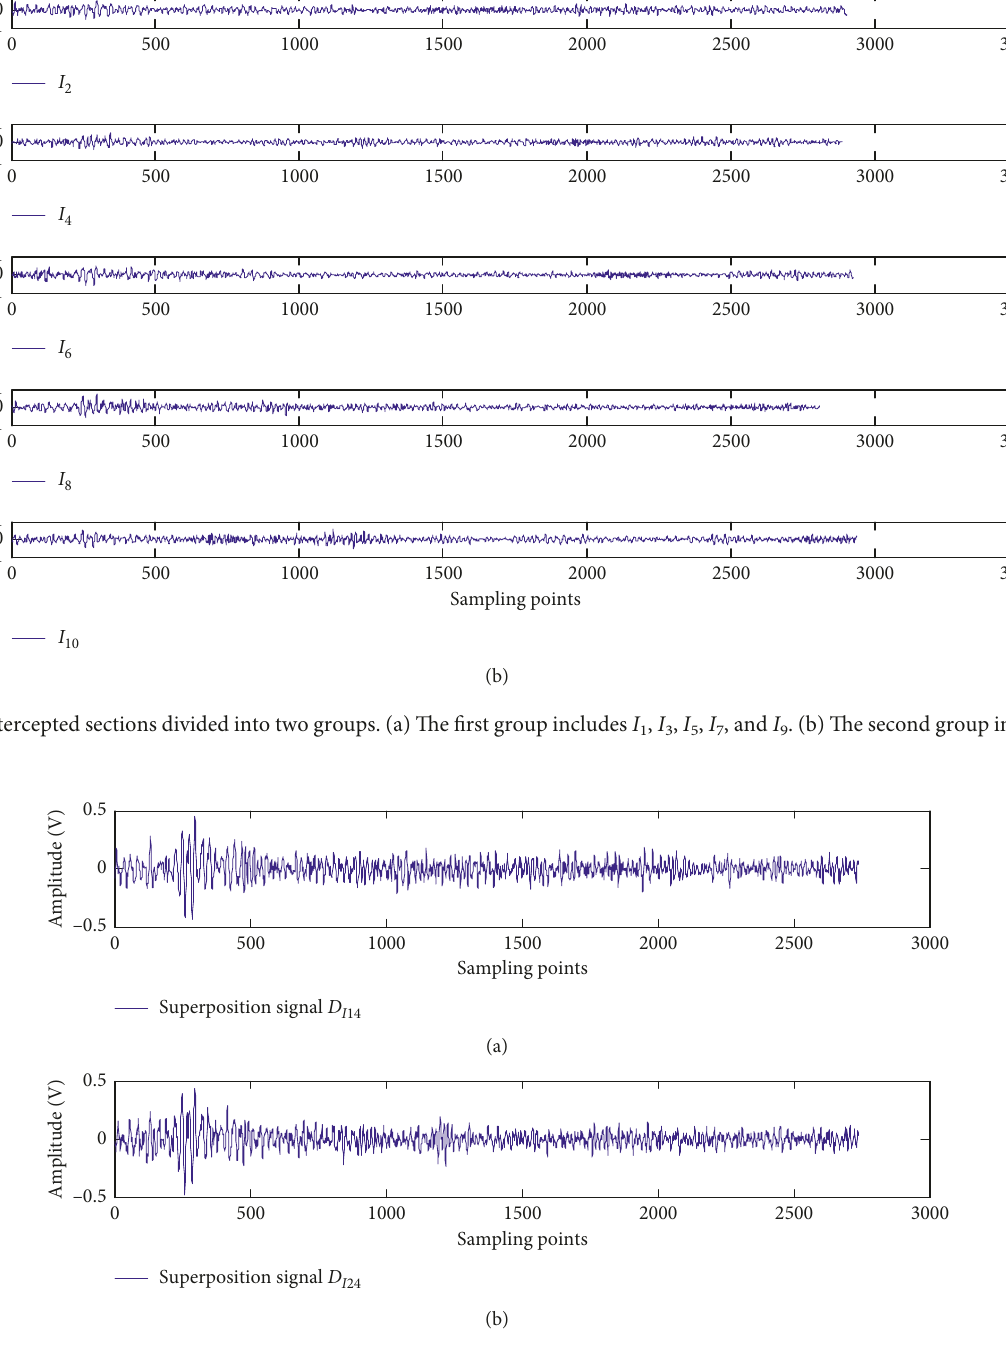
Figure 17: Superimposed sections. D